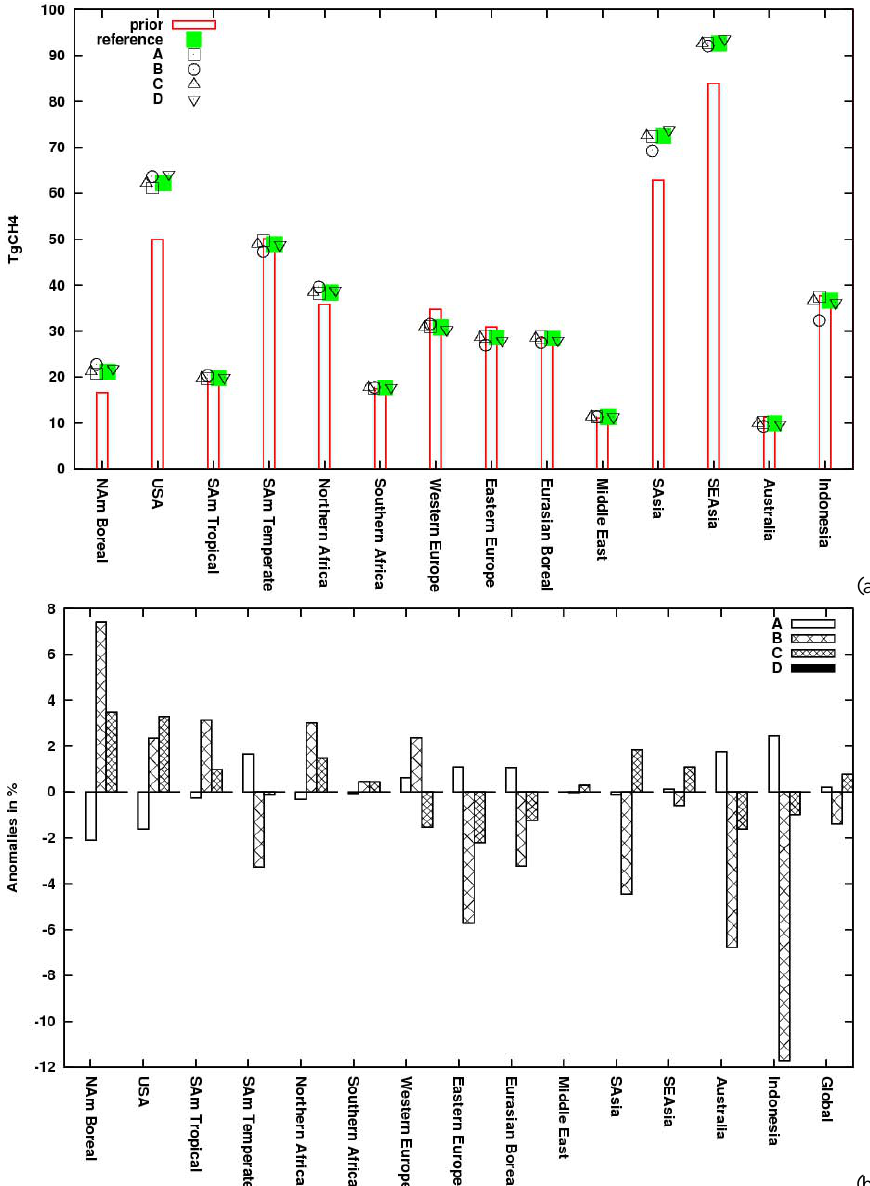
Fig. 12. Same as Fig. 10, but for CH 4